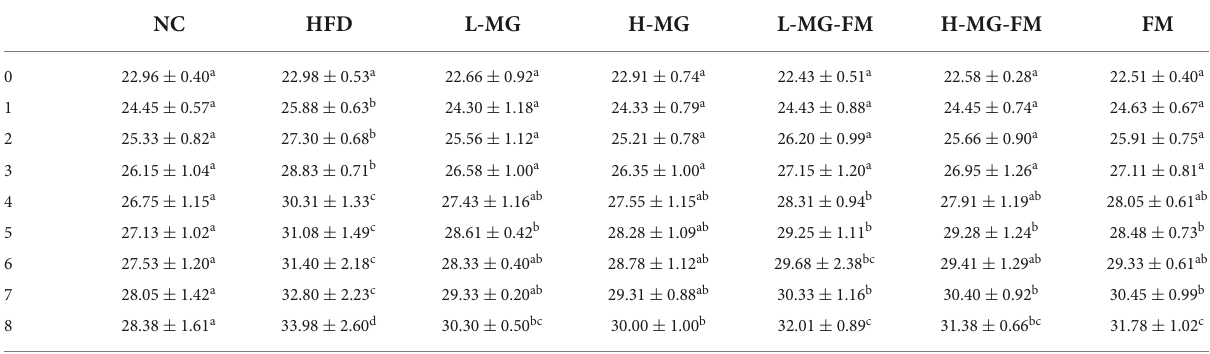
TABLE 2 Trends of body weight in